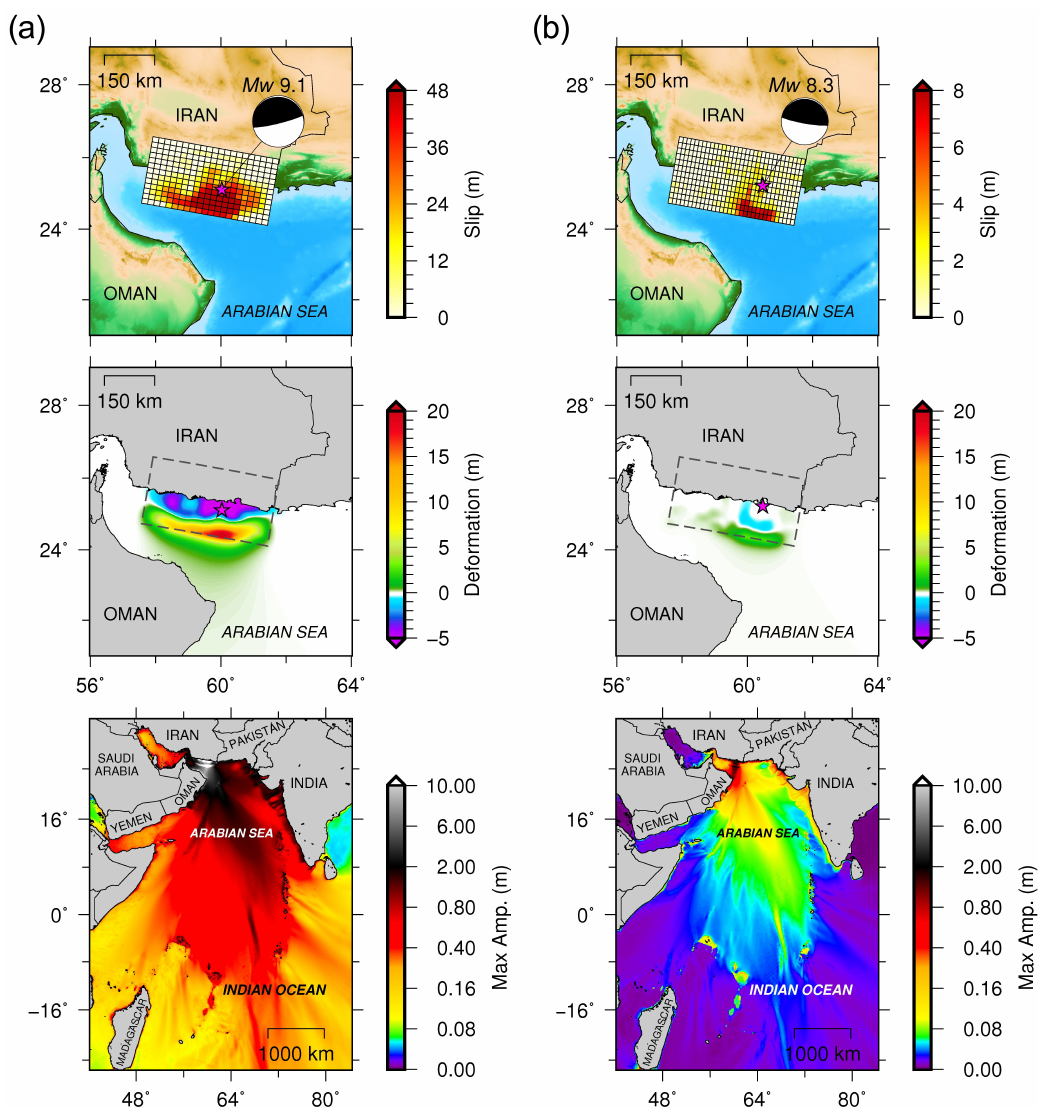
Figure 8. Near-field and far-field tsunami hazard from a 2011 Tohoku-type ( a ) and a 2015 Chile-type ( b ) earthquake scenarios in the western Makran. The top frames show the source models. Purple star is the epicenter. The middle frames show the computed vertical seafloor deformations from the earthquake scenarios. Dashed lines represent the fault plane. The bottom frames show the maximum wave amplitudes from the scenarios. Modified after Rashidi et al.